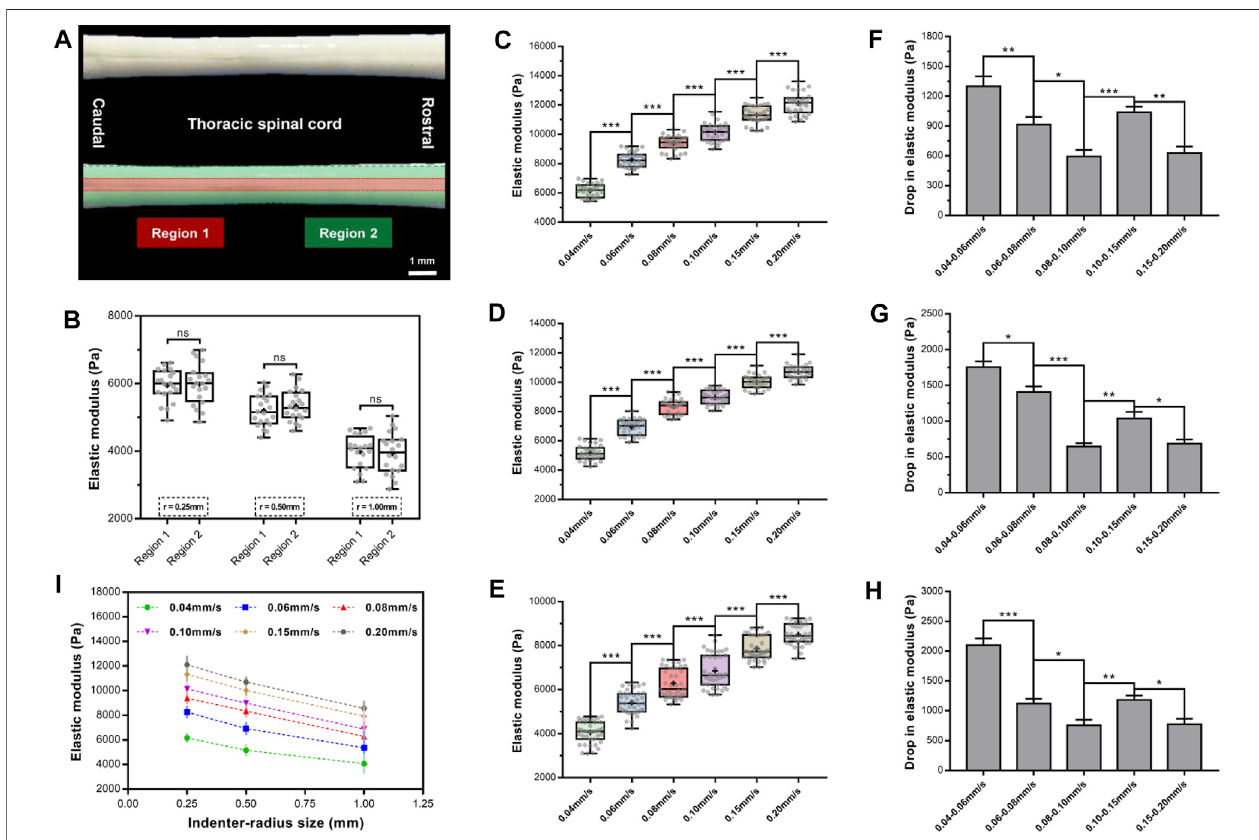
FIGURE 7| Elasticmodulus ofrat SCPC tissueunder a range of rates and indenters ofdifferent sizes. SCPC tissue depicted outlines of region 1 (red) and region 2 (green) (A) . There was no signi fi cant difference in elastic moduli of two regions ( p > 0.05, Turkey ’ s post-hoc tests) (B) . Elastic modulus increased in magnitude with an increase in velocities of indentation for 0.25- (C) , 0.50- (D) , and 1.00-mm (E) radius indenter. A signi fi cantly lower drop in elastic modulus than former group either for 0.02 mm/sintervalor0.05 mm/sintervalwith0.25- (F) ,0.50- (G), and1.00-mm (H) radiusindenter.Elasticmodulusdecreasedwithincreasingindentersizeatany velocity (I) . Error bars are standard error of mean. * p < 0.05; ** p < 0.01; *** p <